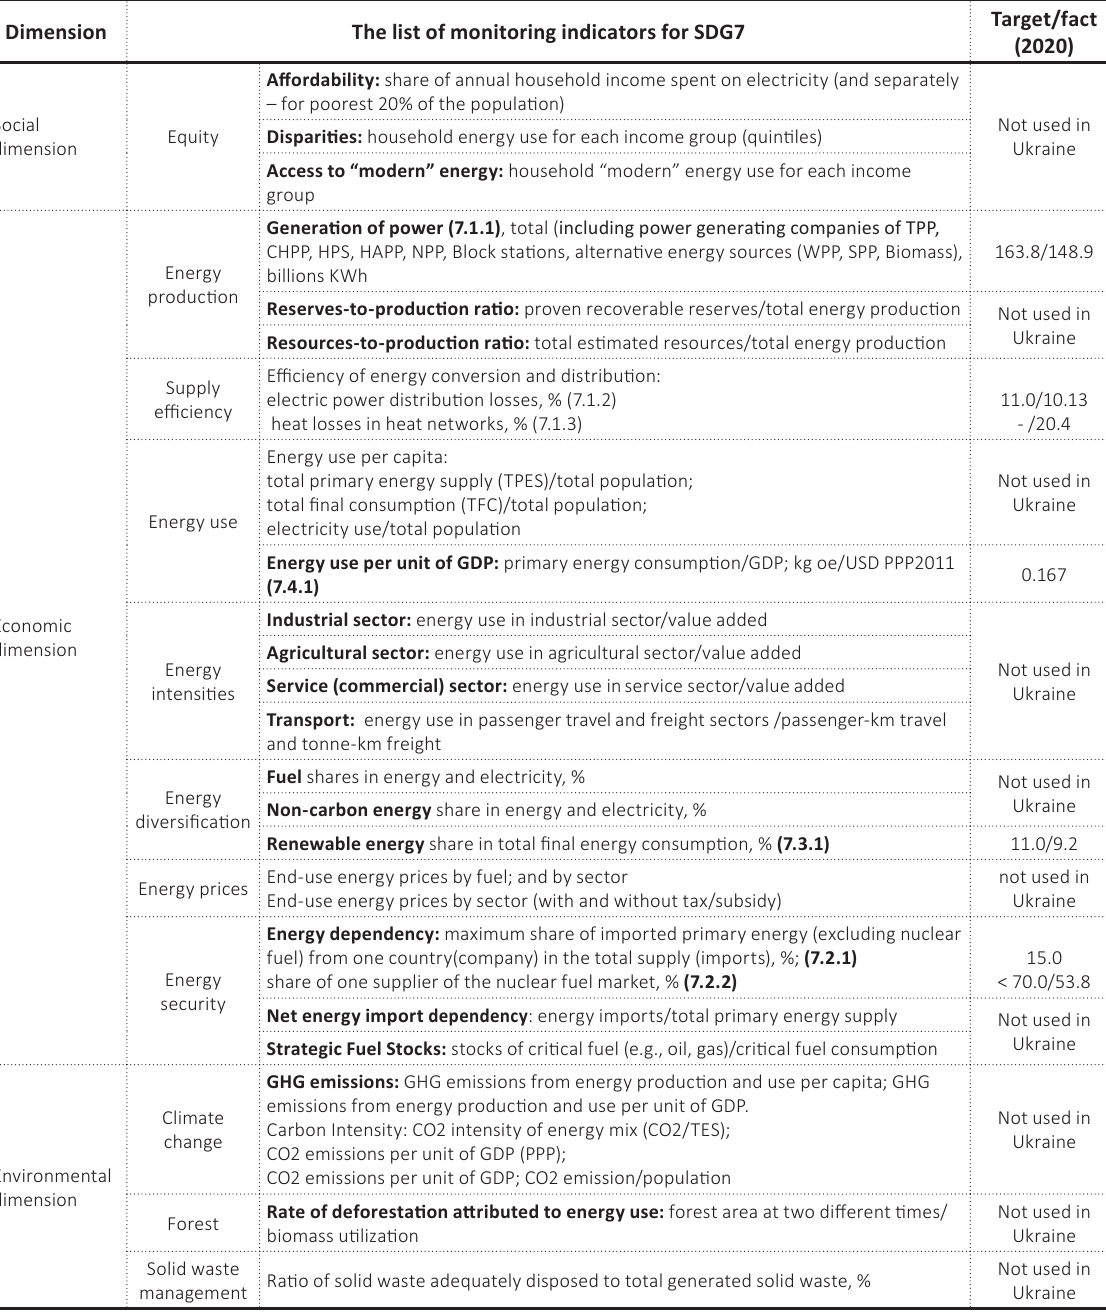
Table 3. Main indicators that are used and can be used in Ukraine to monitor the achievement of SDG7 “Affordable and Clean Energy”